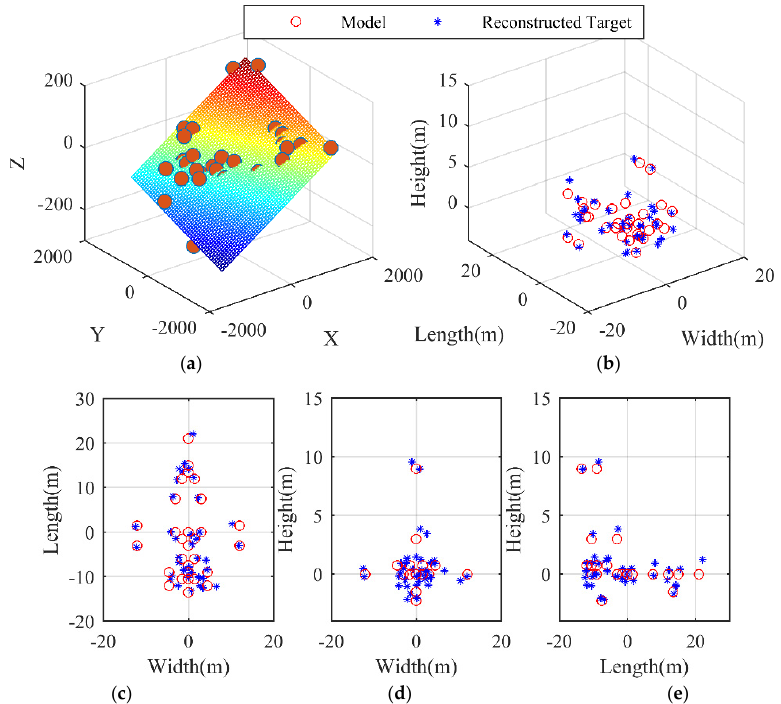
Figure 5. 3D reconstruction results 𝑑𝑣,𝑑ℎ = 0.5 𝑚 . ( a ) Regression plane of parameter estimation in Equation (25). ( b ) 3D reconstruction result of the airplane. ( c ) Range–horizontal direction view ( 𝑦 (cid:2869) − 𝑦 (cid:2870) ). ( d ) Range–vertical direction view ( 𝑦 (cid:2870) − 𝑦 (cid:2871) ). ( e ) Vertical–horizontal direction view ( 𝑦 (cid:2869) − 𝑦 (cid:2871) ).